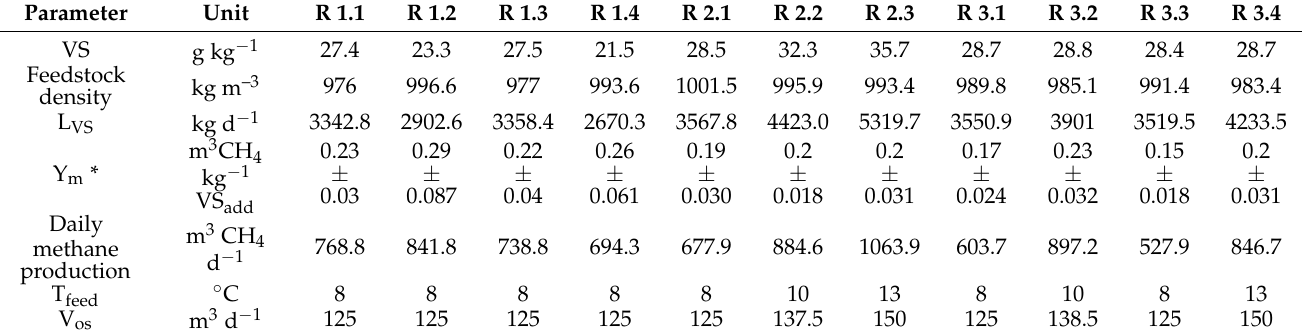
Table 3. Input parameters to evaluate energy balance (* average value and 95% confidence limits are given). Parameter Unit VS Feedstock